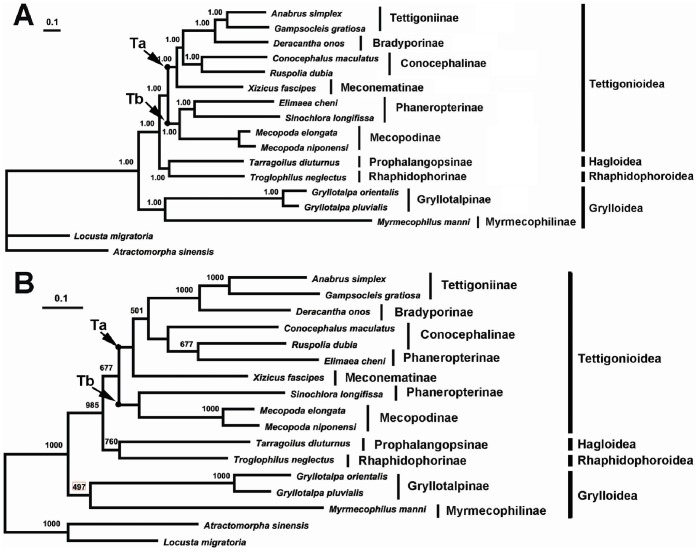
Phylogenetic reconstruction of the Ensifera using mitochondrial PCGs and rRNAs concatenated dataset.(A) Bayesian result, applicable posterior probability values are shown; (B) Maximum likelihood result with applicable bootstrap values (>50%) are shown.